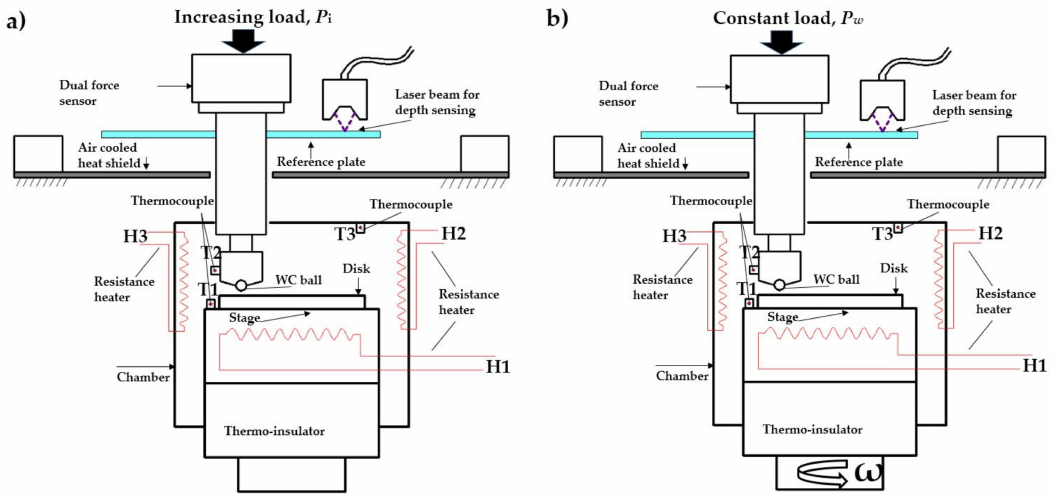
Figure 1. Schematic of the joint test rig for high temperature micro-indentation and wear test: ( a ) for indentation test; ( b ) for wear test.